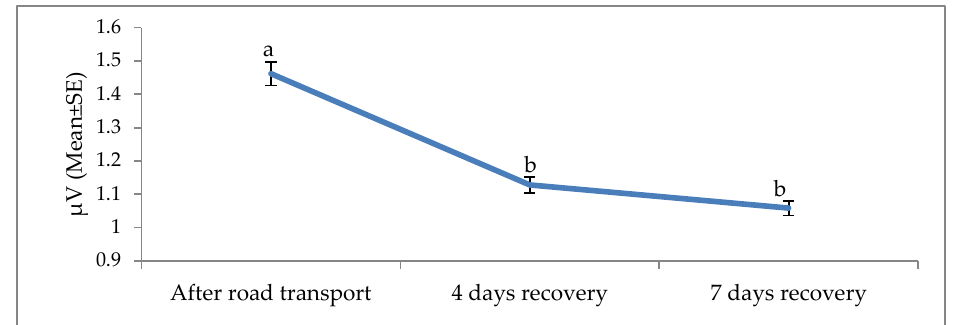
Figure 4. Effects of road transport on the alpha root mean square (RMS) in cattle. The number of animals used in each sampling point was 24 heifers. Means with different letters are significantly different at p < 0.05.